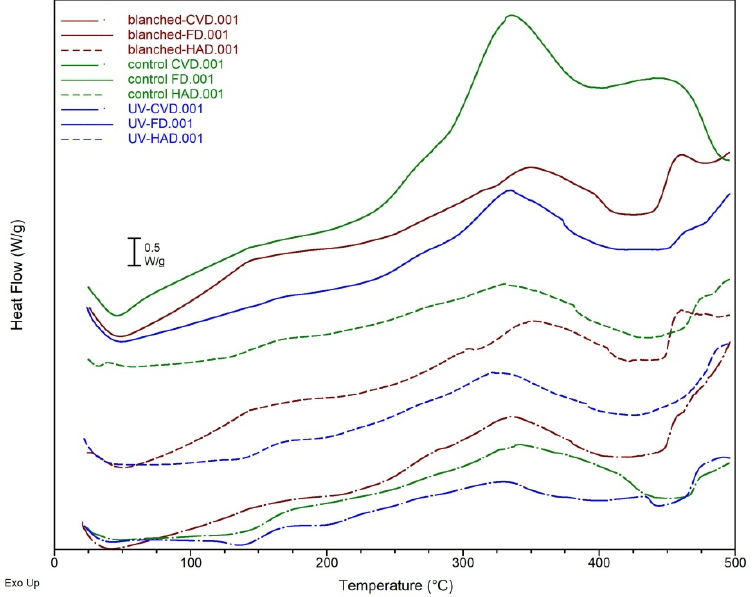
Figure 7. DSC thermograms of B. edulis mushrooms subjected to different pretreatment and drying methods for the temperature range of 25–500 °C.